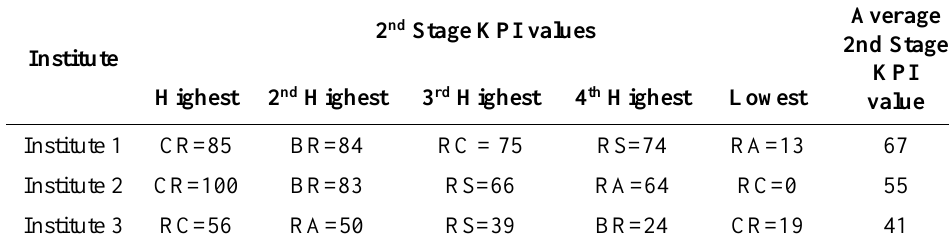
Table 7: Summary of Performance Based on Second Stage KPI Values of